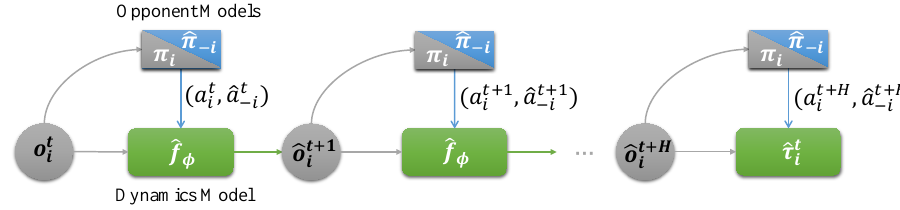
Figure 2. Imagined